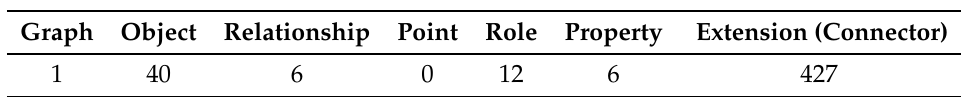
Table 2. Metamodel elements included in a